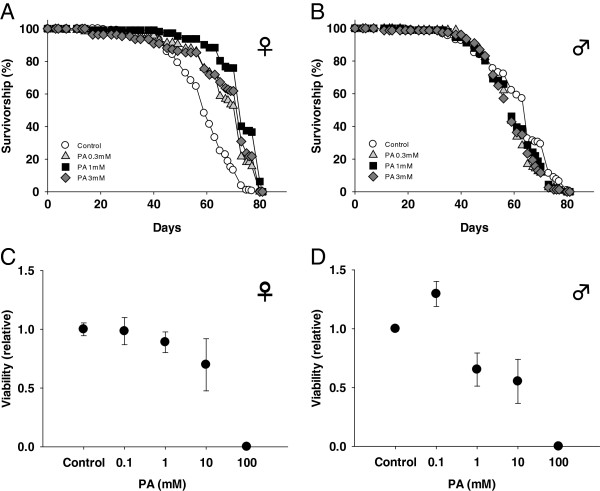
Effects of PA on the lifespan and egg-to-adult viability of Drosophila. (A) Survival curves of females kept on media containing PA. The mean lifespan of female Drosophila kept on 0.3, 1 and 3 mM PA was increased by 13%, 23% and 13%, respectively (p<0.001; log-rank test). (B) The survival curves of males revealed no effects of PA. (C) The viability of females was not affected at concentrations of up to 10 mM. (D) The viability of males was reduced by PA, even at 1 mM. Larval development was arrested at 100 mM in both genders (p<0.05, t-test).